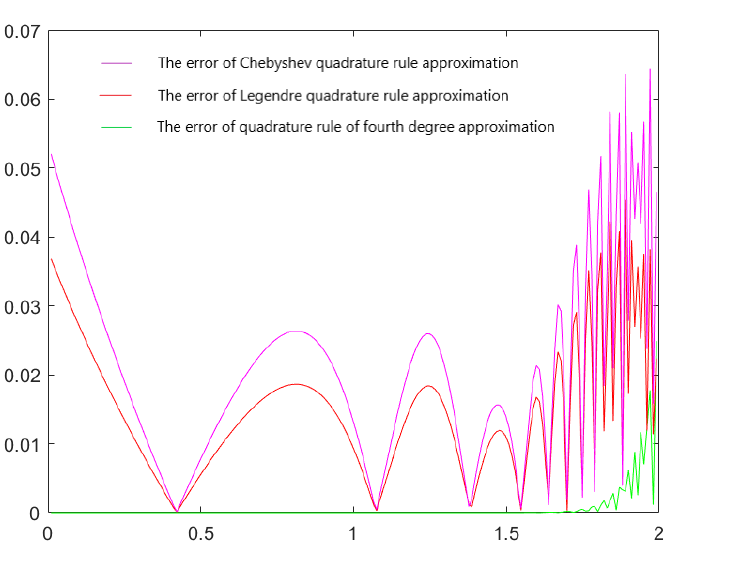
Figure 6. Error functions of three approximations of the original function in Example 4, given by inverse F 3 -transforms calculated using the Legendre, Chebyshev and the suggested quadratures. In the latter case, the errors are zero almost